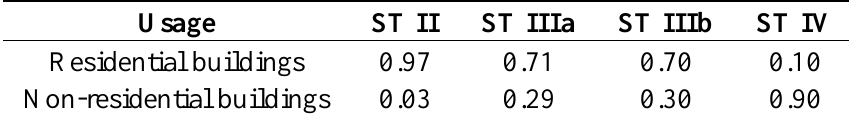
Table 2. Characteristic shares of residential and non-residential buildings for the structure types. Source: